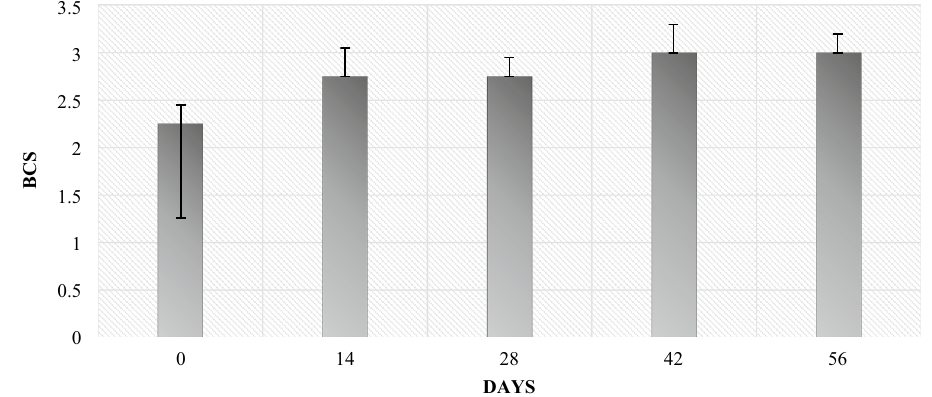
Figure 1. The condition of ewes from the day of birth to 56 days after lambing (no significant differences between periods were found).